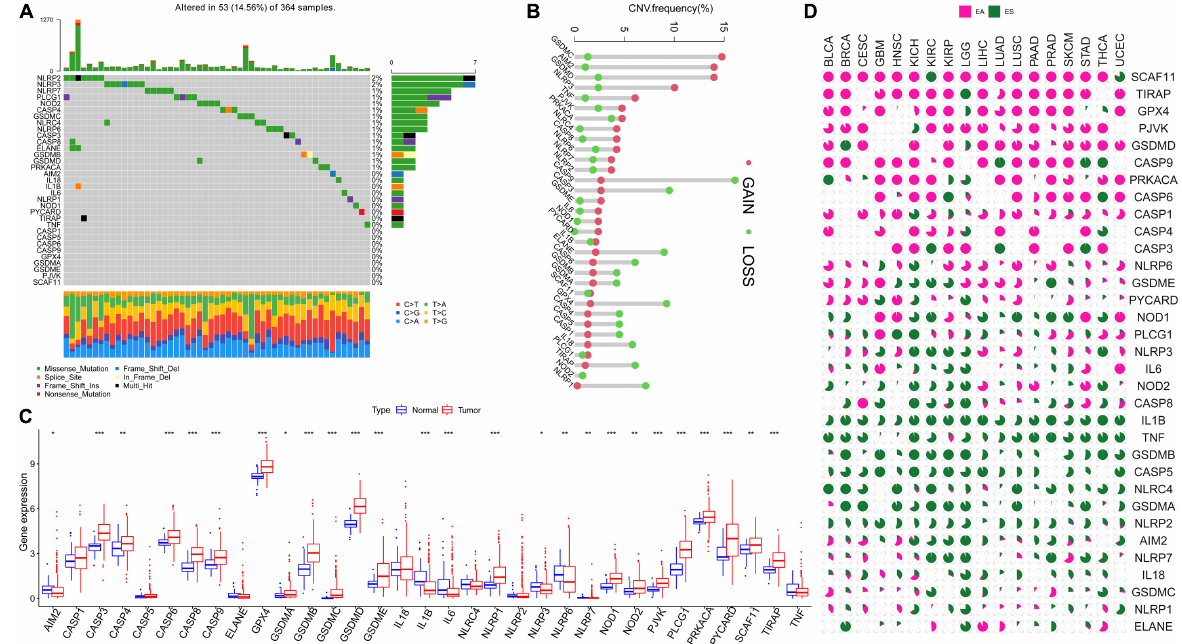
Frontiers in Cell and Developmental Biology |